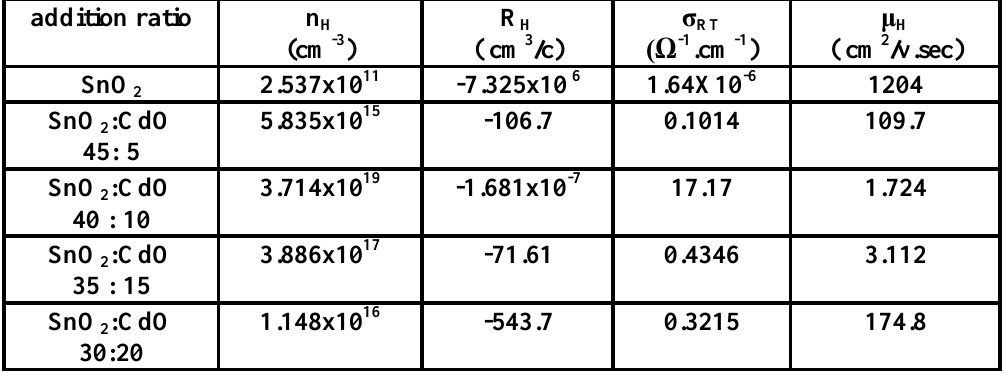
thin films at different mixed ratio of CdO. 2